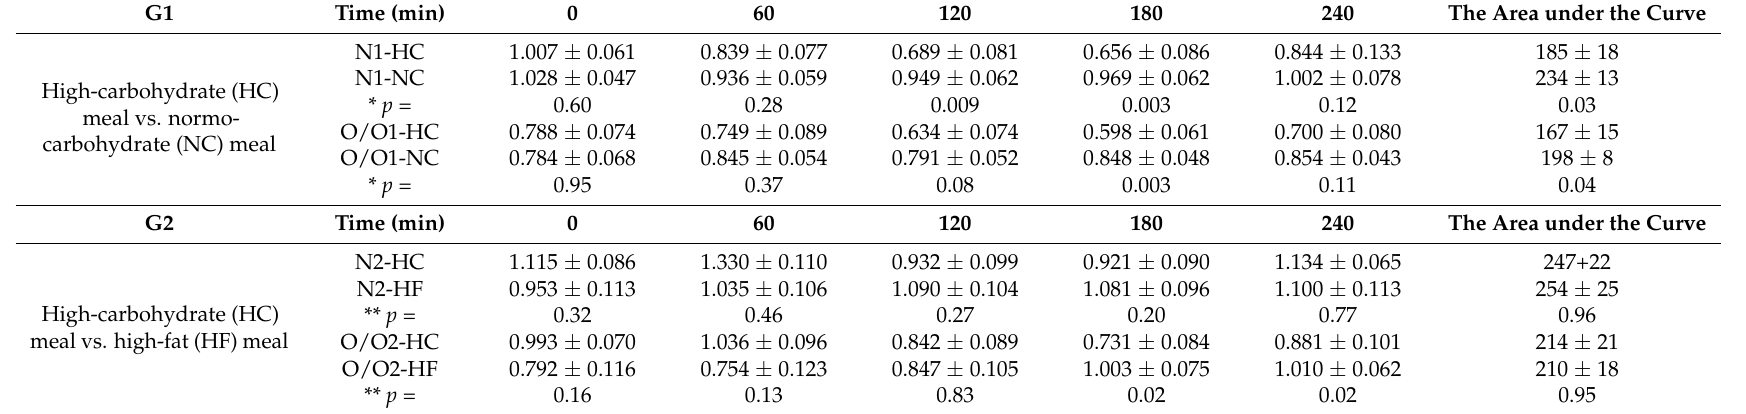
Table 5. Fat oxidation (mg/kg/min) in men from Group I (G1, with normal body weight N1 and with overweight/obesity O/O1) on fasting (0 min) and in crossover trials after intake (60–240 min) of high-carbohydrate (HC) meal and normo-carbohydrate (NC) meal and men from Group II (G2, with normal body weight N2 and with overweight/obesity O/O2) on fasting (0 min) and in crossover trials after intake (30–240 min) of high-carbohydrate (HC) meal and high-fat (HF) meal. G1 Time (min) 0 240 The Area under the Curve High-carbohydrate (HC) meal vs.